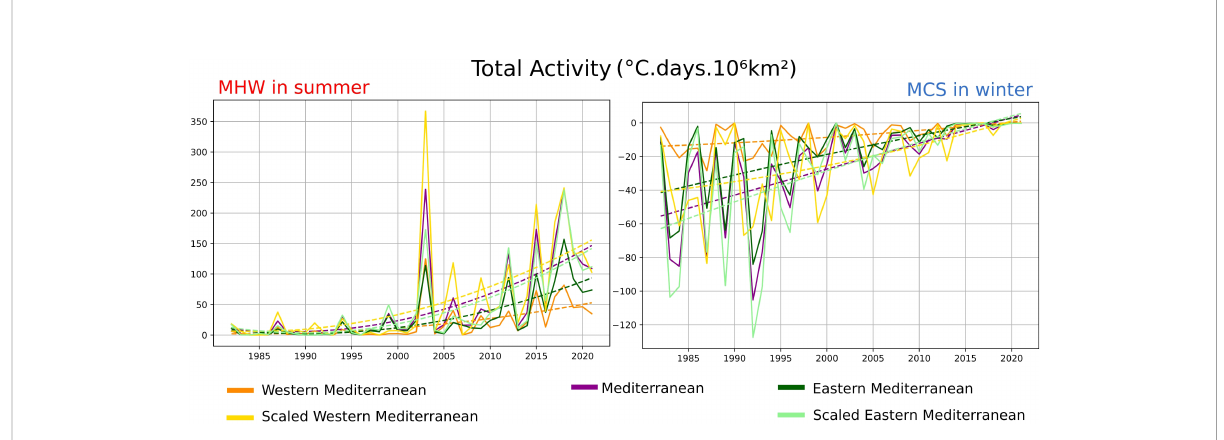
FIGURE 6 Times series of total activity and size-scaled total activity (°C x days x 10 ⁶ km²) of the MHWs in JJAS (left) and MCSs in DJFM (right) in the Mediterranean (magenta line), the western Mediterranean (orange line) and the eastern Mediterranean (green line). Dash lines represent quadratic regression of the solid line with the same